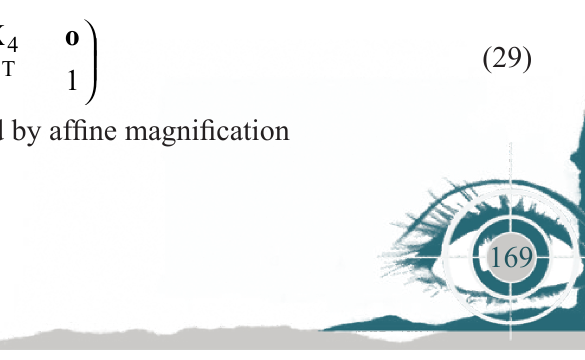
The South African Optometrist